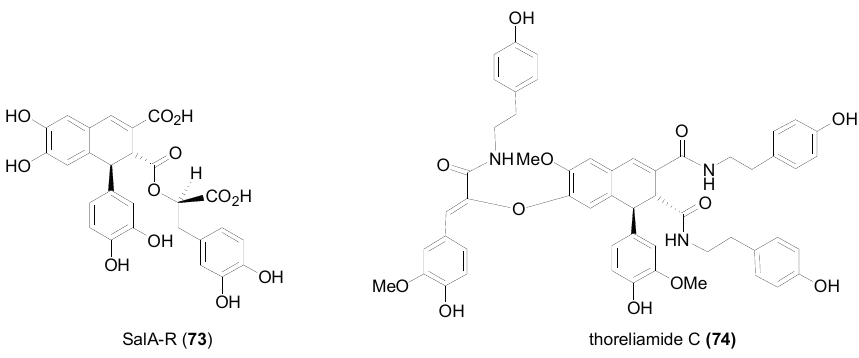
Figure 2. Structures of naturally occurring lignans incorporating a 1,2-dihydronaphthalene